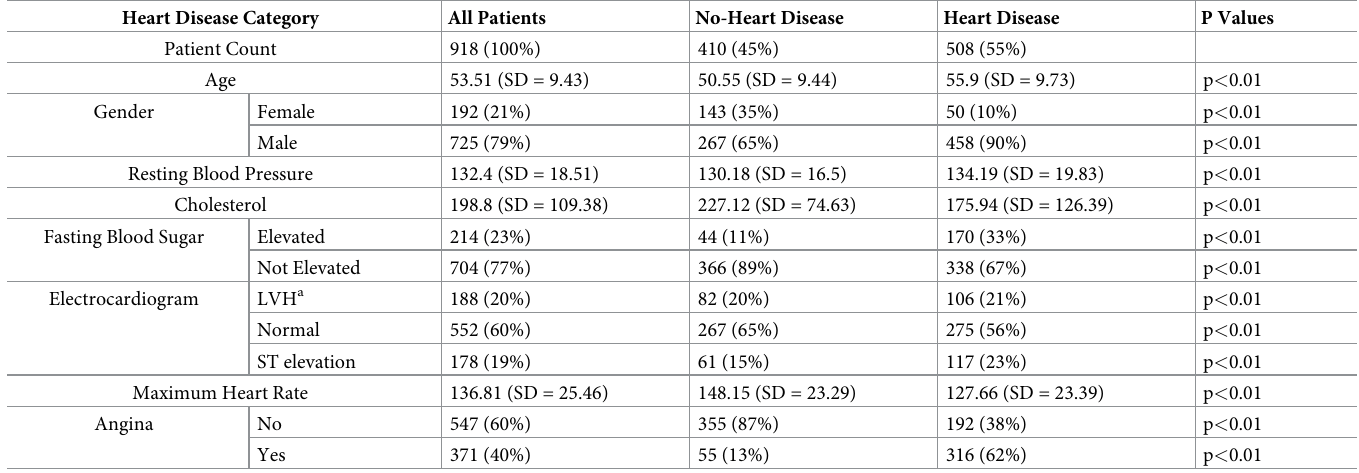
Table 1. Summary of cohort demographics and disease characteristics. Heart Disease